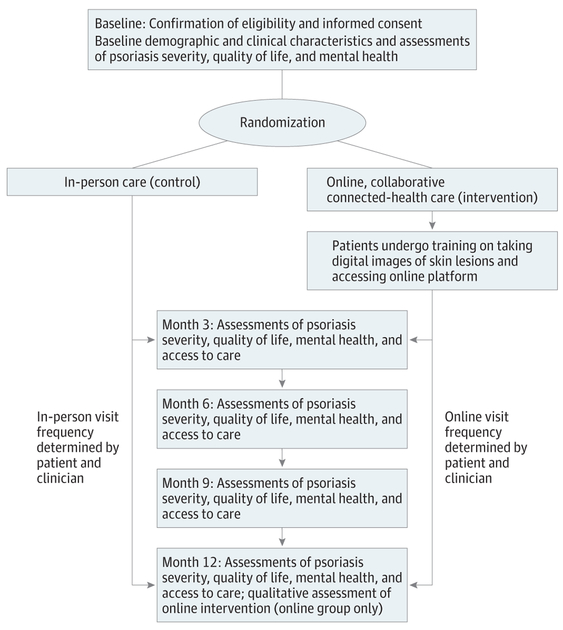
Overview of Pragmatic Randomized Clinical Trial Comparing Online vs In-Person Care in Patients With Psoriasis